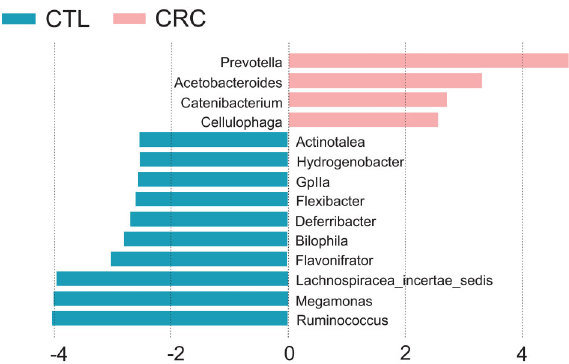
Figure 3. Linear discriminants analysis (LDA) associated with effect size (LEfSe) showing differences in genus between the colorectal adenocarcinoma (CRC) patients and control (CTL) subjects (rate with an LDA score 4 2.5 and a signi fi cance of o 0.05 determined by the Wilcoxon signed